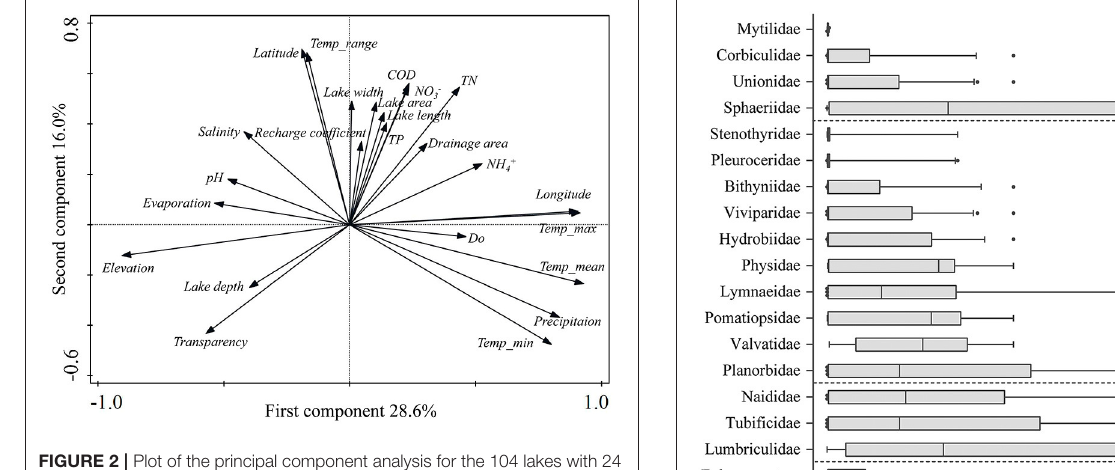
FIGURE 2 | Plot of the principal component analysis for the 104 lakes with 24 environmental variables in China and India. COD, chemical oxygen demand; DO, water dissolved oxygen; NH + 4 , ammonium nitrogen; NO − 3 , nitrate nitrogen; Temp_mean, annual mean temperature; Temp_max, maximum temperature of the warmest month; Temp_min, minimum temperature of the coldest month; Temp_range, temperature annual range; TN, total nitrogen; TP, total phosphorus.